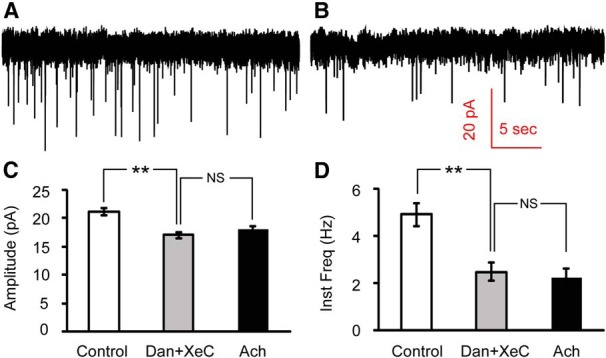
Inhibiting calcium release from internal stores occludes the effect of ACh on mEPSCs onto Hcrt+ neurons. A, B, mEPSCs recorded at baseline (A) and after 30 min incubation with the ryanodine receptor antagonist dantrolene (50 μM) and the IP3 receptor antagonist (−)-Xestospongin C (5 μM; B). C, D, Mean values of amplitude (C) and instantaneous frequency (D) of mEPSCs at baseline, after 30 min incubation with dantrolene (Dan) and XeC and upon subsequent ACh puff in the continued presence of dantrolene and XeC. n = 3 cells. Both amplitude and instantaneous frequency were significantly decreased by dantrolene+XeC, but there was no significant difference between mEPSC recordings in the presence of dantrolene and XeC and upon subsequent ACh puffs in the continued presence of these inhibitors. **p < 0.01; NS, not significant (p > 0.05).